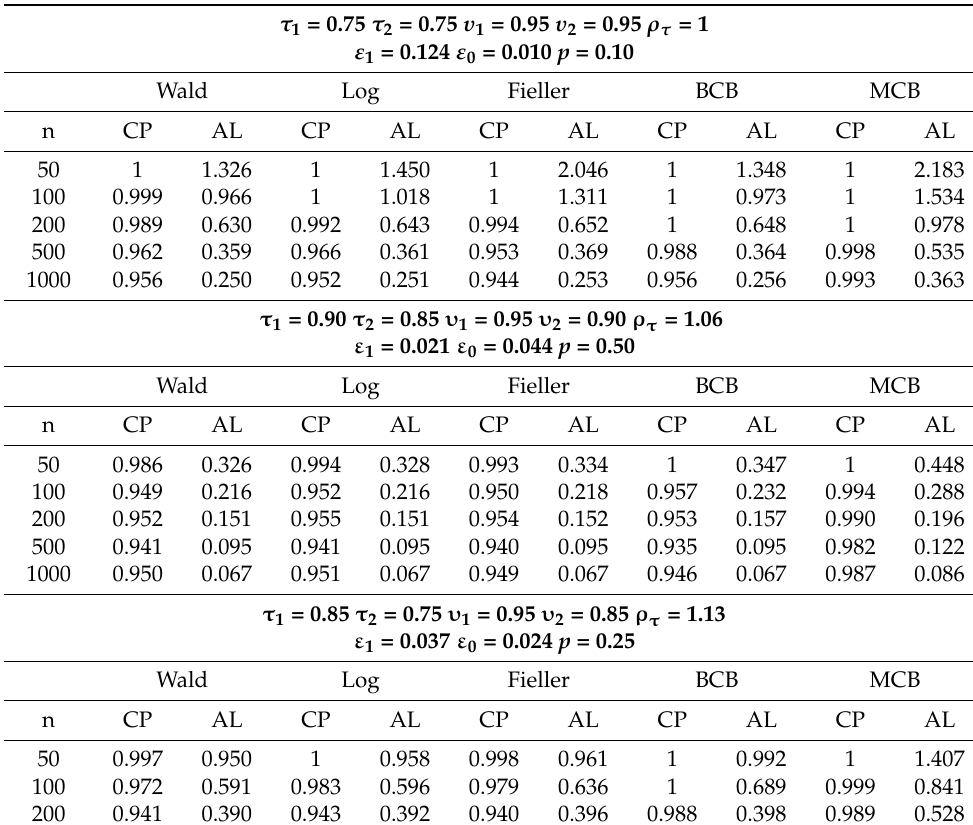
Table 3. Asymptotic behaviors of the CIs for the ratio of the two positive predictive